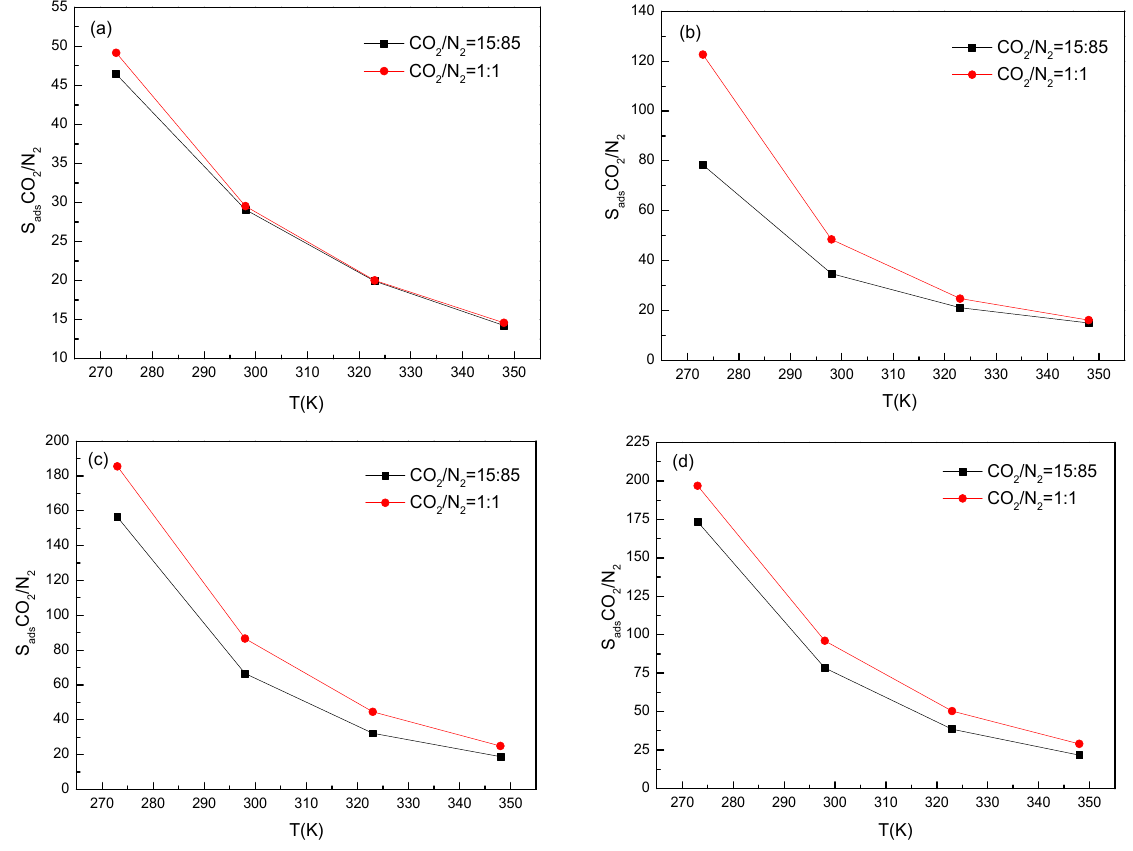
Figure 8. The adsorption selectivity for equimolar and 15:85 binary mixtures of CO 2 /N 2 at ( a ) 0.005 MPa; ( b ) 0.1 MPa; ( c ) 1 MPa; and ( d ) 2 MPa as a function of